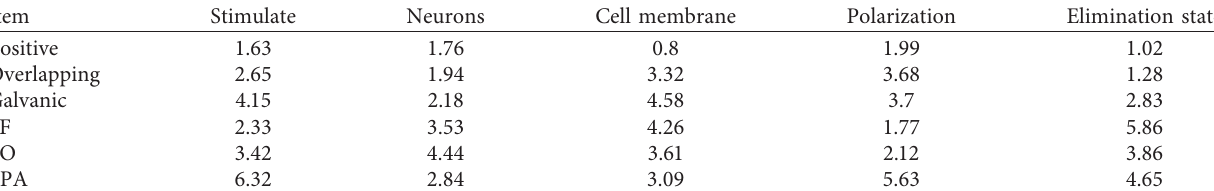
Table 9: Visual channels play a leading role in pleasure.